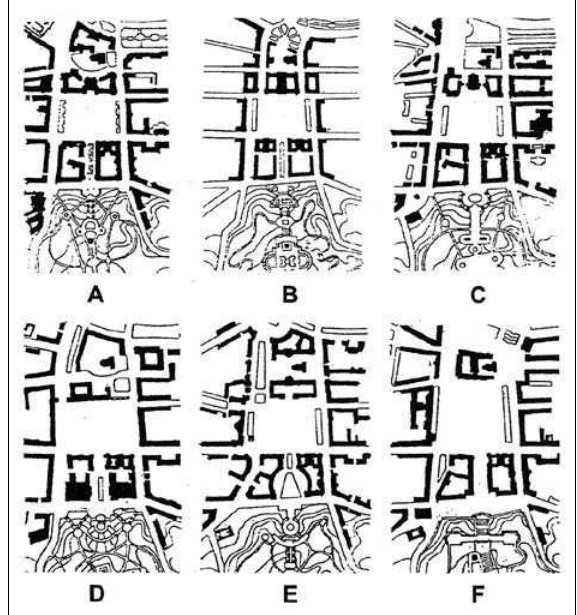
Fig. 2. Layouts of Lukiškės Square in competitive urban projects for the centre of Vilnius, 1945.